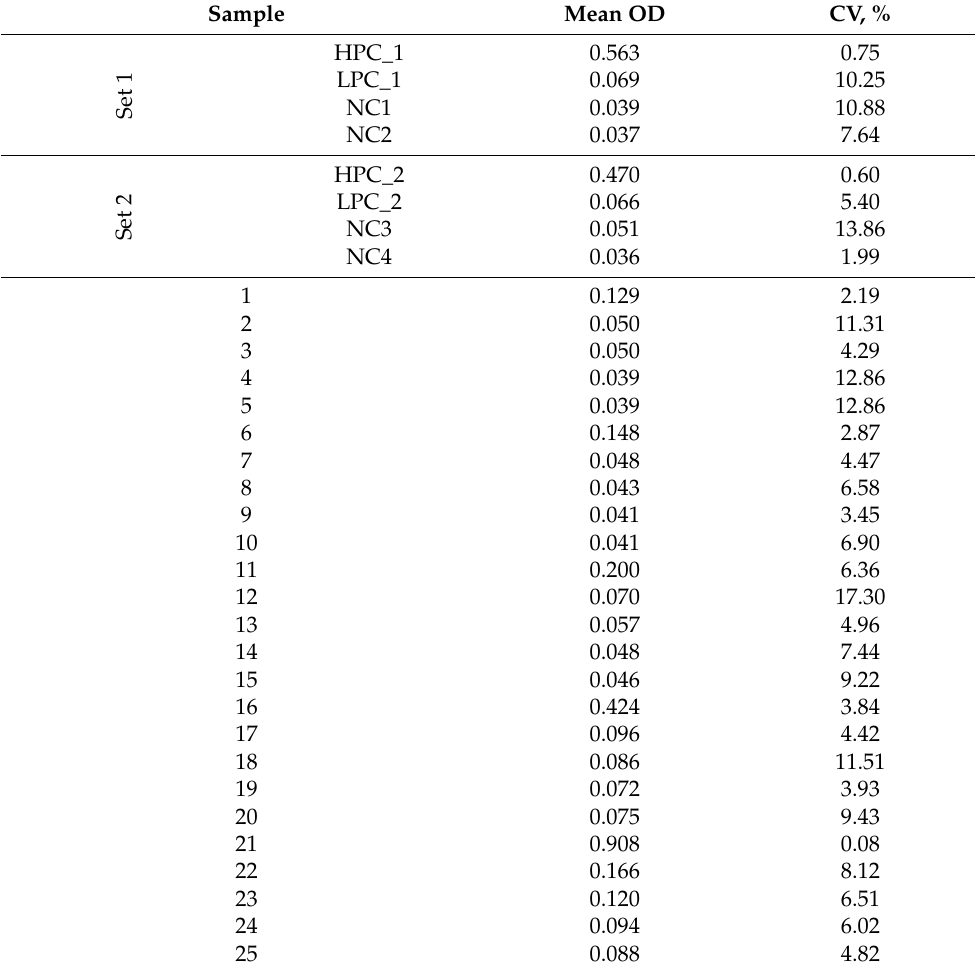
Table 7. Calculations and results of method drug tolerance evaluation to the presence of